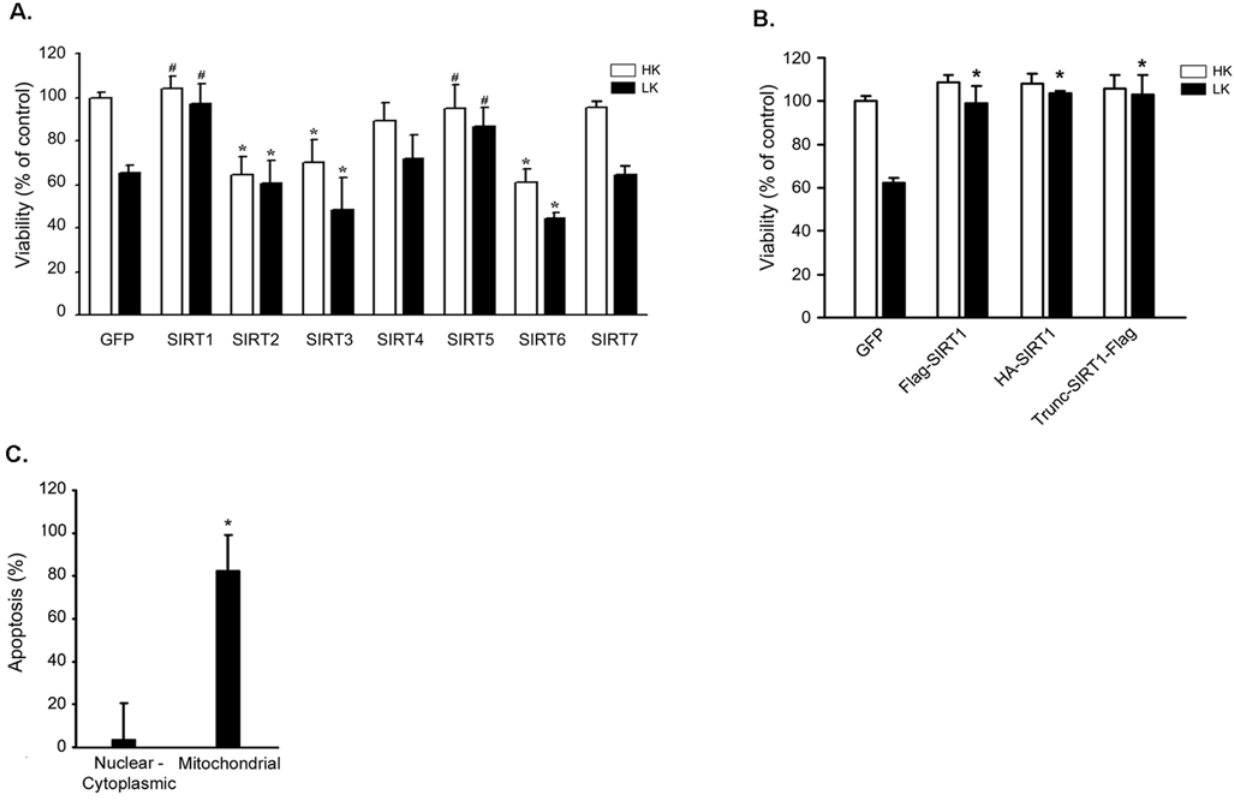
Figure 1. Effect of SIRT 1–7 expression on neuronal survival. (A) Sirtuin family expression and cerebellar granule neuron survival. Expression plasmids encoding Flag-tagged forms of SIRT 1–7 were transfected into CGNs and the cultures were switched to HK or LK medium. The proportion of transfected neurons that were apoptotic was quantified 24 hrs after the switch and compared with control cultures which were transfected with CMV-GFP. Viability for transfected cells was determined using DAPI staining of chromatin (*indicates p , .05 compared with GFP HK (control); # indicates p , .05 compared with GFP LK). (B) Expression of other SIRT1 constructs in neurons confirms neuroprotection. Neurons were transfected with Flag-SIRT1 (tag on the N-terminus), HA-SIRT1, or Trunc-SIRT1-Flag and switched to HK or LK medium. The proportion of transfected neurons that were apoptotic was quantified 24 hrs after the switch and compared with control cultures which were transfected with CMV-GFP. Apoptosis was determined for transfected cells using DAPI staining (* indicates p , .05 compared with GFP LK; control=GFP HK). (C) SIRT5 localization and CGNs survival. SIRT5 localization in CGNs was determined by immunocytochemistry following SIRT5-Flag transfection and viability assessed using DAPI staining 24 after HK and LK treatment. The localization of viable and apoptotic SIRT5-Flag expressing cells was scored as nuclear and cytoplasmic or mitochondrial (* indicates p , .05 compared with nuclear-cytoplasmic).